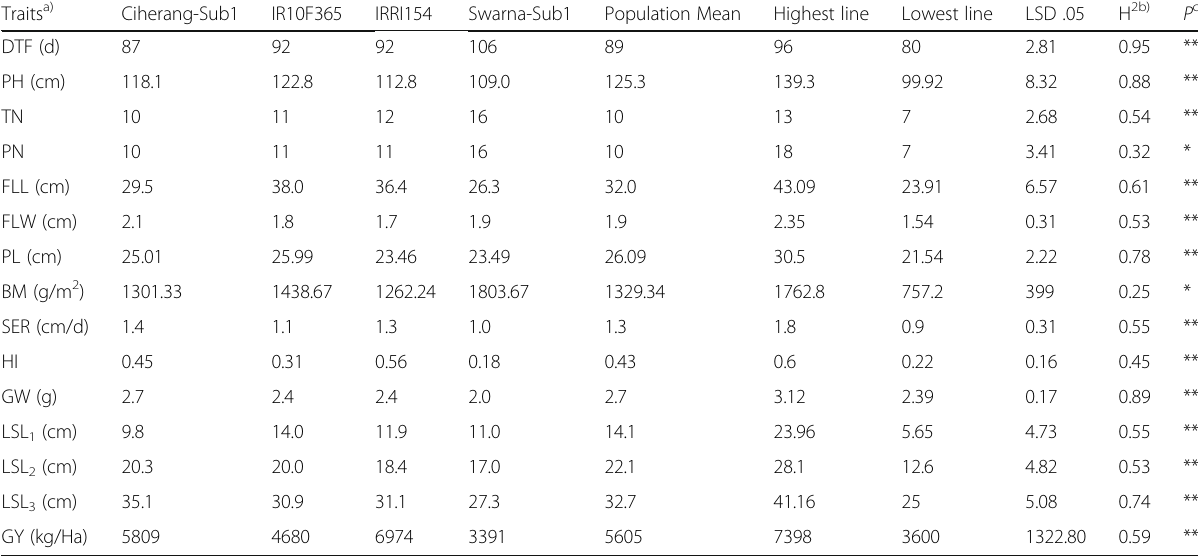
Table 2 Descriptive statistics of each trait in the mapping population, parents, and checks under irrigated control condition Traits